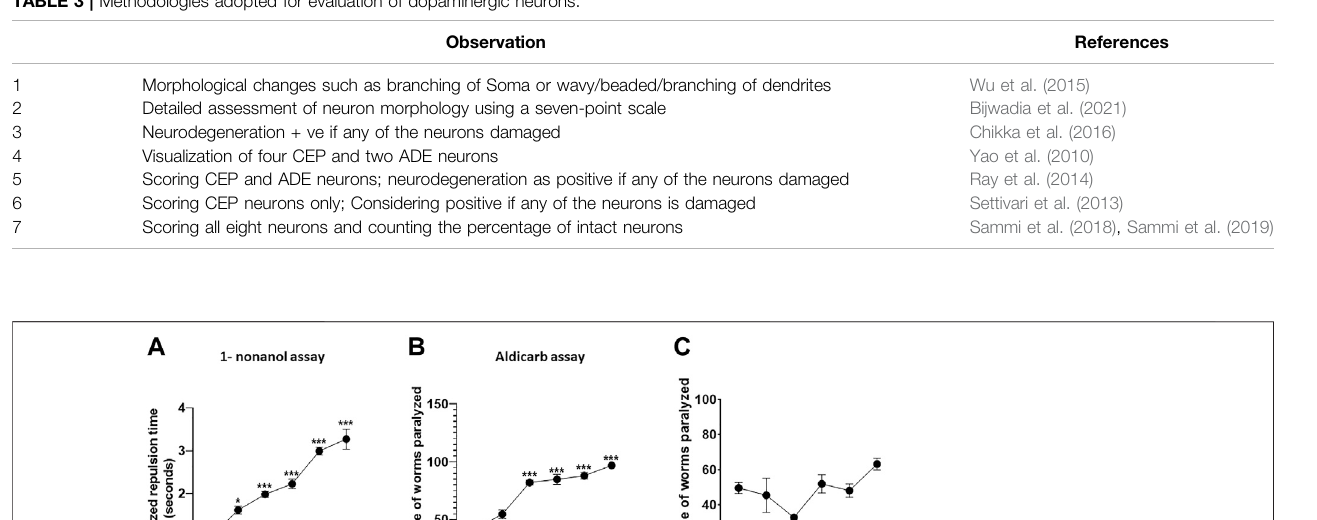
Frontiers in Toxicology |